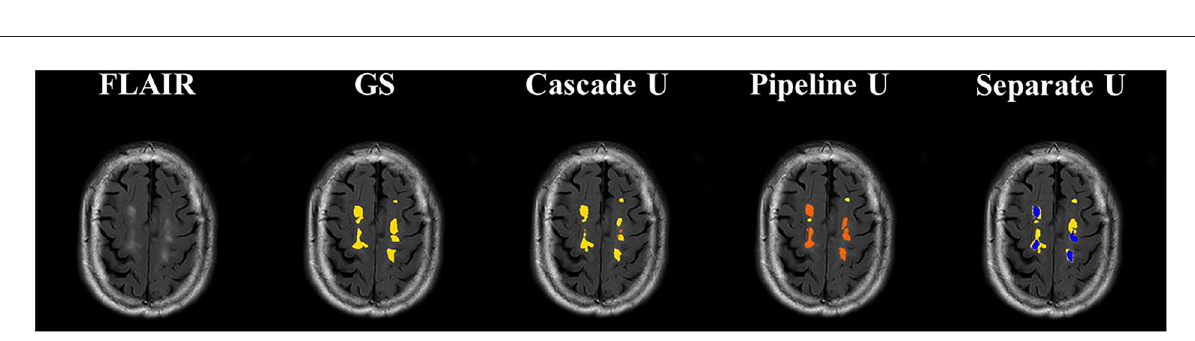
FIGURE6 Illustration of segmentation results of dWMHs. Orange represented pvWMHs, yellow represented dWMHs, and blue represented the overlaps of the model prediction. GS, gold standard.